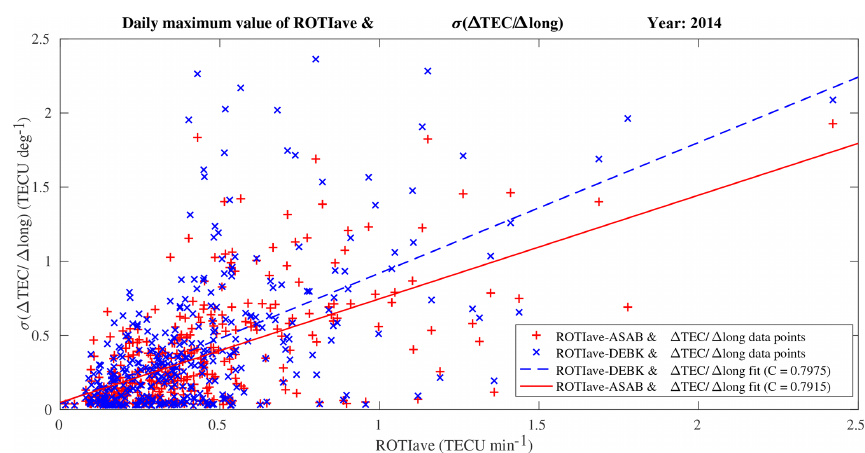
Figure 9. Relation between the daily maximum value of σ((cid:49) TEC /(cid:49) long ) and the daily maximum value of ROTI ave over ASAB (red, + ) and DEBK (blue, × ) in the year 2014. The blue broken and solid red lines indicate the linear fit between the daily maximum value of σ((cid:49) TEC /(cid:49) long ) and ROTI ave for ASAB and DEBK,